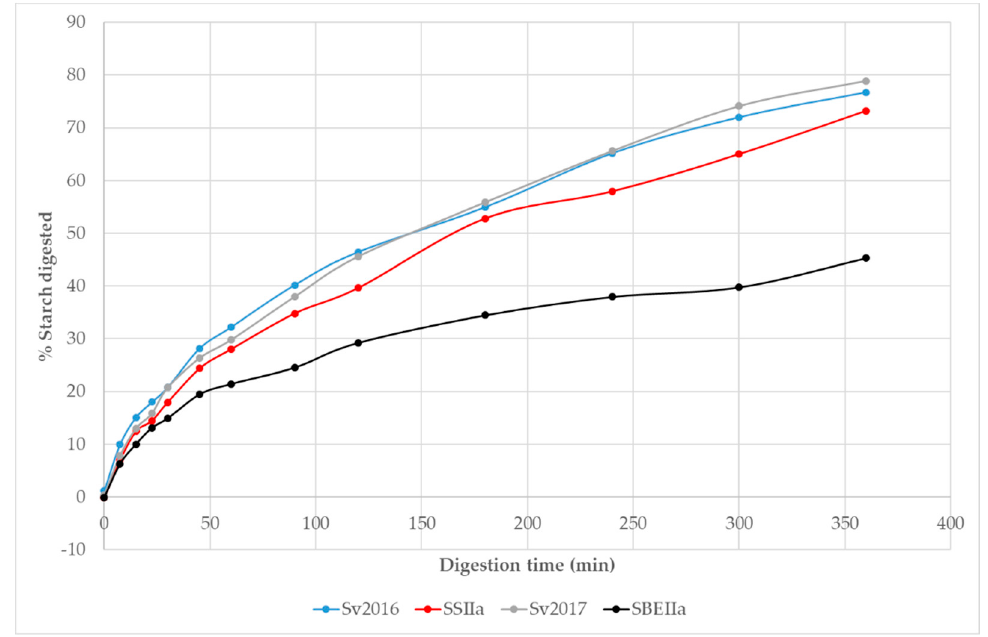
Figure 3. Digestibility curves obtained for cooked pasta of HA and control genotypes digested by α amylase/amyloglucosidase.